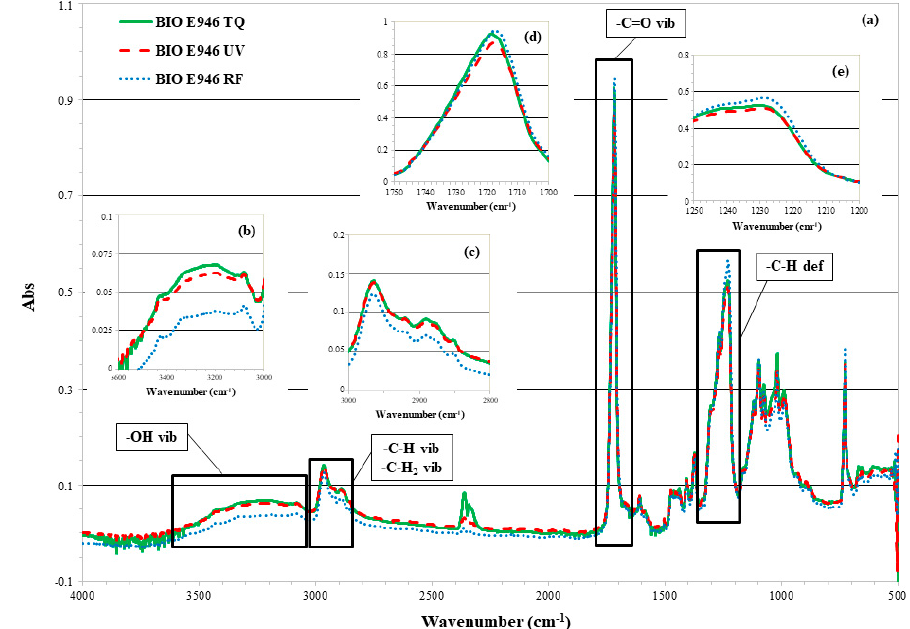
Figure 2. ATR-FTIR spectra of ( a ) BIO E946, before (TQ) and after UV and RF treatments; expansions